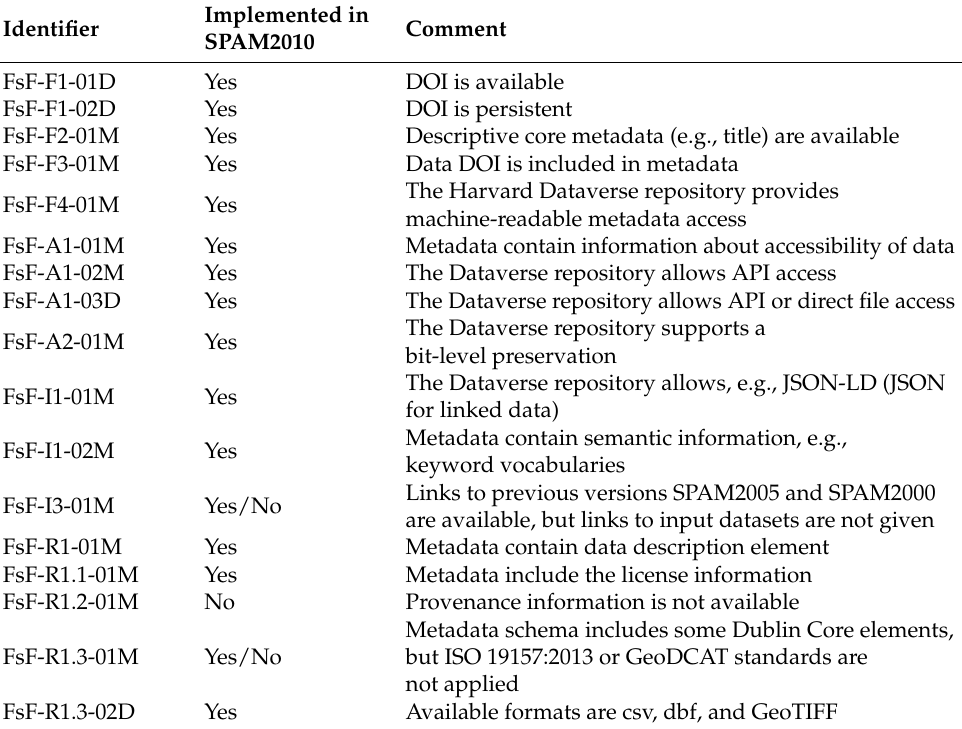
Table 15. FAIRsFAIR indicators assessment for SPAM2010 example data (identifier descriptions are listed Table